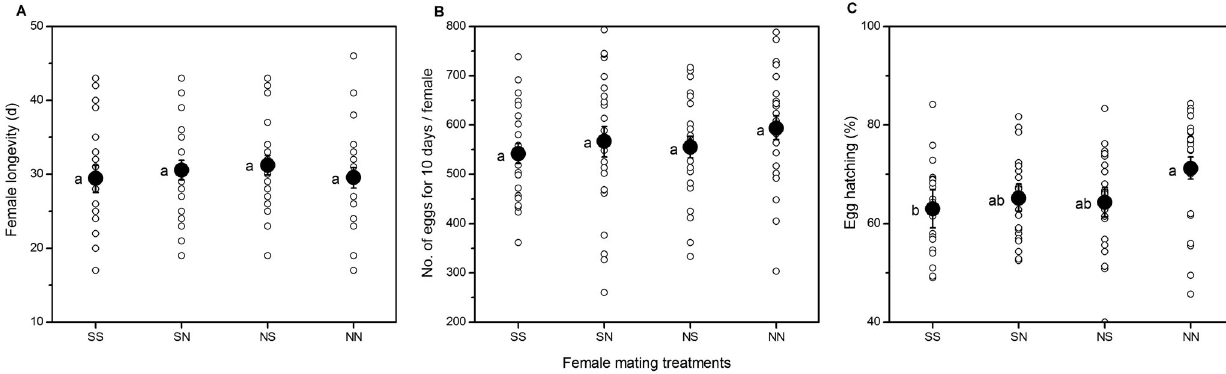
Figure 2. Variation in female fitness parameters among treatment groups. Effect of treatment groups on (A) longevity, (B) fecundity and (C) fertility for doubly mated C. bowringi females under four treatments: mated to two sibling males (SS), mated to a sibling followed by a non-sibling male (SN), mated to a non-sibling followed by a sibling male (NS), and mated to two non-sibling males (NN). Black circle dots and error bars represent mean and standard error. Different letters indicate significant differences based on ANOVA with Tukey’s HSD post hoc analyses ( P , 0.05).